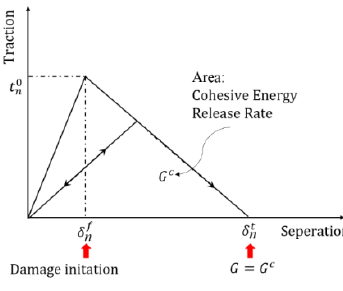
Figure 2. Cohesive traction-separation relation based on cohesive zone method (CZM).